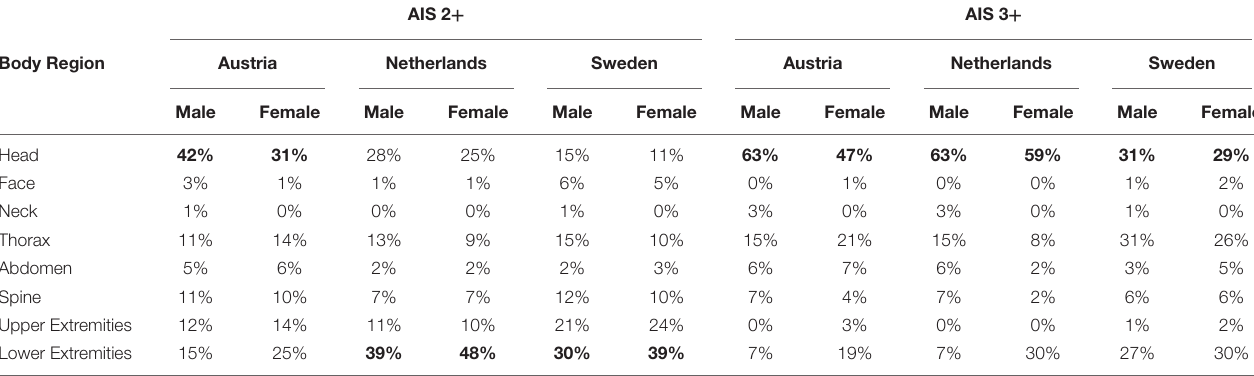
TABLE 3 | Share of injured body regions for AIS2 + and AIS3 + in the three different databases for pedestrians and cyclists together. AIS 2 + AIS 3 + Body